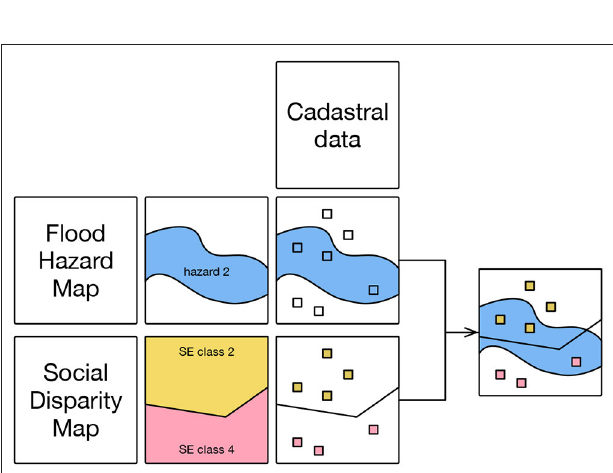
FIGURE 3 | Combination of flood hazard and socio-economic data at the building level through the use of cadastral data. Squares represent building footprints. Cadastral data provides information about the number of housings per building. The combination of the data sets results in a database of housings with a given index of social disparity (ISD) class and a given hazard level covering the entire territory. This is used for estimating the number of households exposed to a certain level of hazard along the different socio-economic